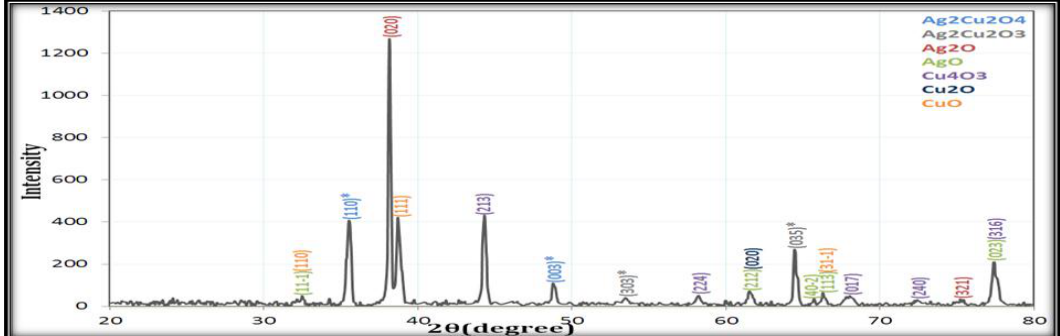
Fig. 4: The X-ray diffraction pattern of Ag